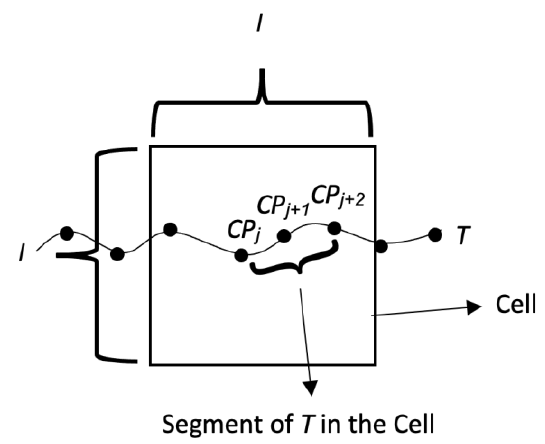
Figure 3. Segment of a trajectory T in a cell of a spatiotemporal scenario.